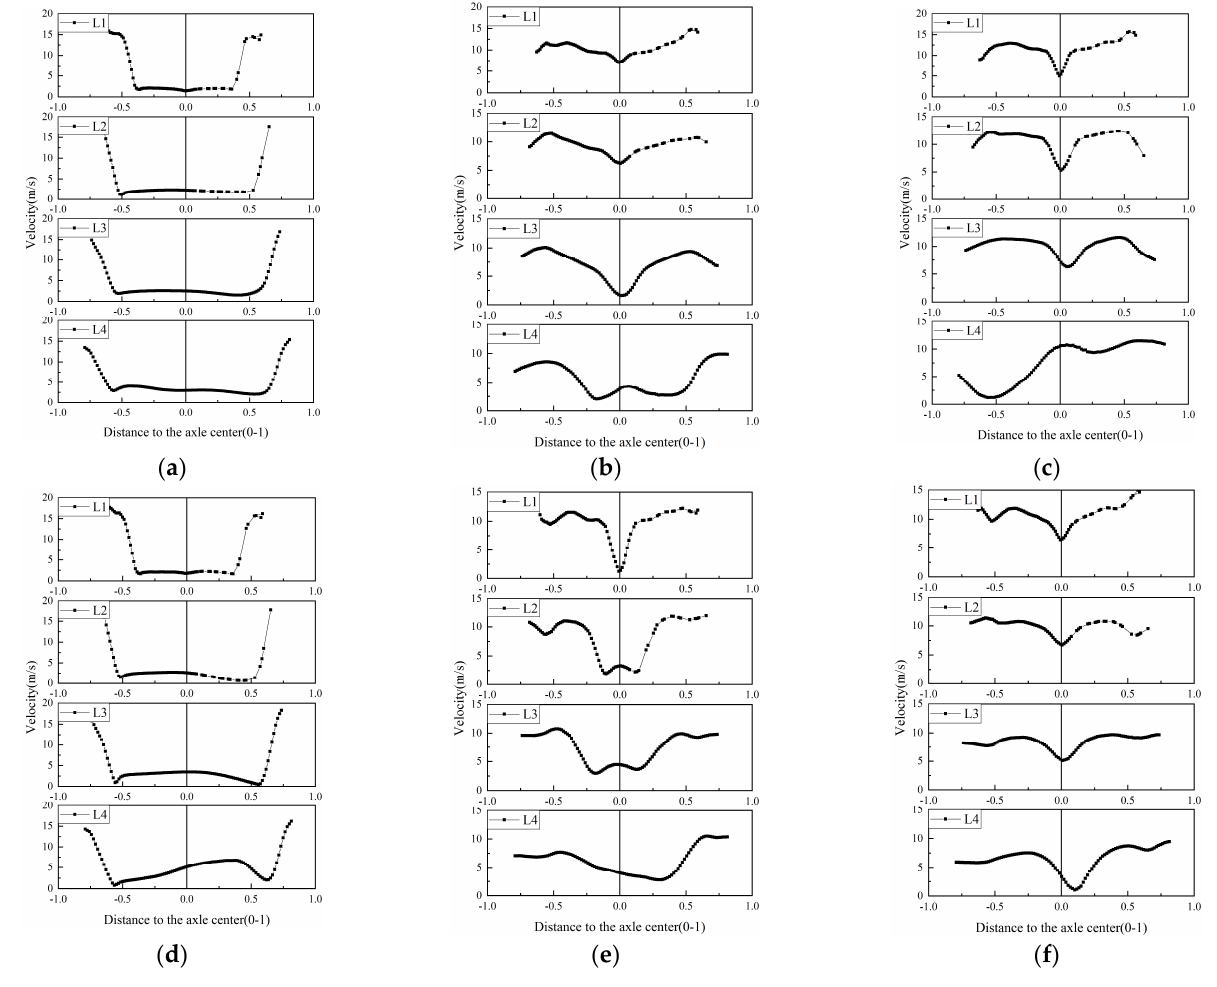
Figure 16. Velocities at the X-axis of the draft tube in CFD result. ( a ) OP1, ( b ) OP2, ( c ) OP3, ( d ) OP4, ( e ) OP5, and ( f ) OP6.